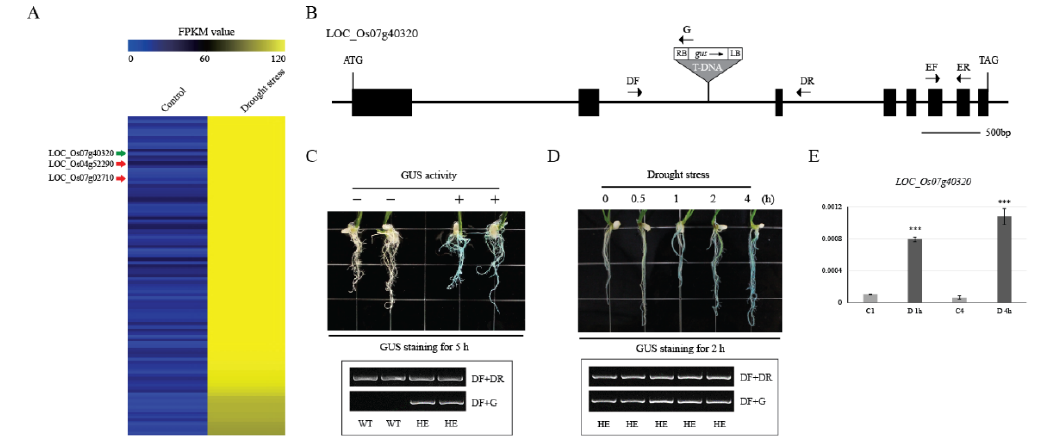
Figure 4. Heat map analysis of drought-inducible genes and confirmation using the promoter trap system. Using RNA-seq data processing, we identified 100 drought-inducible genes ( A ). A schematic diagram of the T-DNA insertion site in LOC_Os07g40320 of PFG 3A-01968 is shown ( B ). To identify in planta expression of selected candidates, we germinated the seeds for one promoter trap line in Murashige and Skoog (MS) medium for 7 d and air-dried the plantlets for 0–4 h. Whole seedlings were then incubated in GUS-staining solution ( C , D ). Expression of LOC_Os07g40320 was significantly up-regulated by drought stress, based on qRT-PCR ( E ). Blue indicates the lowest GUS expression level, and yellow indicates the highest GUS expression level. FPKM, fragments per kilobase per million fragments mapped ( A ). Black boxes, exons; white boxes, UTR; lines between boxes, introns; gray triangle, T-DNA insertion; small arrows, gene-specific primers (DF and DR, genotyping primer; EF and ER, expression primer). ATG and TGA indicate start and stop codons, respectively ( B ). C1, and C4, untreated control corresponding to plants under 1 h of drought stress (D 1 h) and 4 h of drought stress (D 4 h); *** p < 0.001 ( E ).